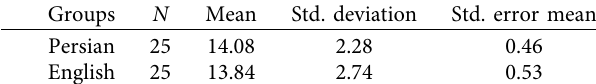
Table 1: Descriptive statistics (pre-test of both